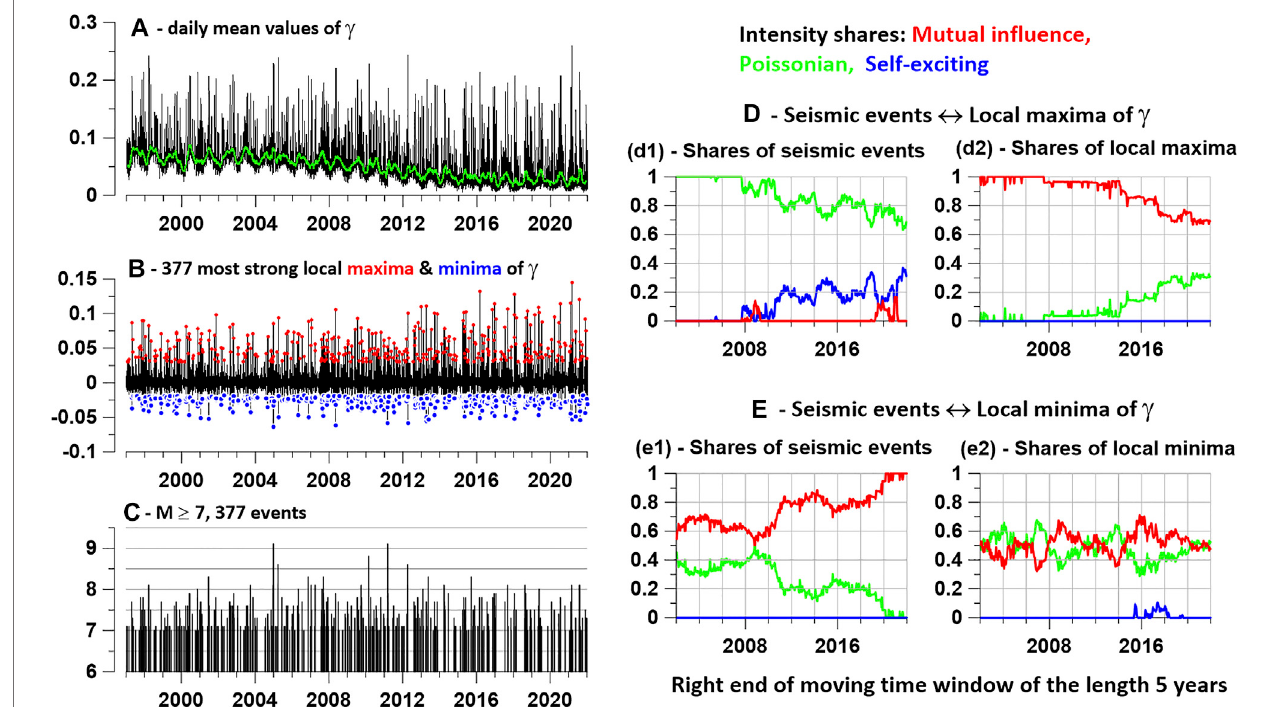
FIGURE 2 | (A) — graph of daily average values of the index γ calculated for all reference points, green line - moving average in a window of 57 days; (B) — graph of average values of the index γ after removal of local trends by a Gaussian window with a radius of 2 days, red and blue dots indicate the 377 most pronounced local maximaand minimaoftheDJindex γ afterdetrending; (C) — thetimesequenceof377earthquakeswithamagnitudeofatleast7forthewholeworld forthetimeinterval 1997 – 2021; (D) and (E) — pairs of graphs representing the shares of intensities of sequences of seismic events [(d1) and (e1)] and points of local extrema of the DJ index [(d2) and (e2)] when estimating the model of mutual in fl uence of 2 point processes in a window of 5 years for the relaxation time τ 15 days.